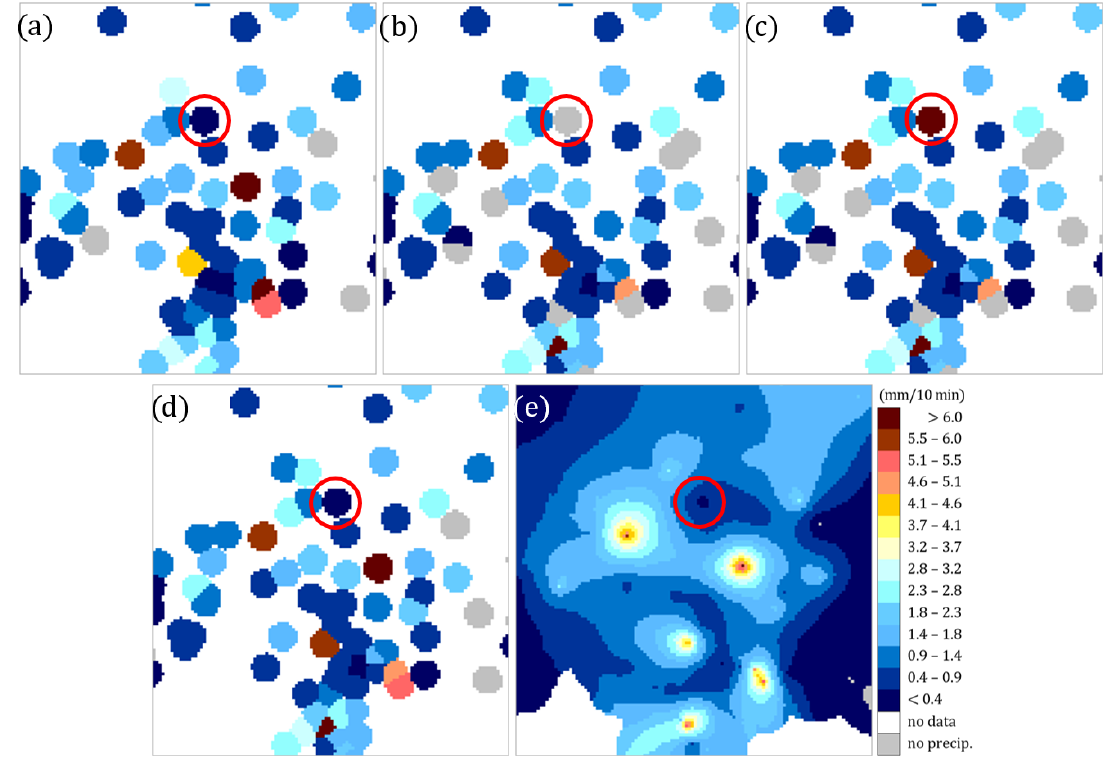
Figure 7. Example of the RainGaugeQC performance after the introduction of an erroneous precipitation value: (a) original rain gauge data from unheated sensors ( G uh ; in all fields the Siercza rain station is marked with a red circle), (b) original data from heated sensors ( G h ) , (c) data from heated sensors disturbed with an artificial value at Siercza (10mm/10min), (d) rain gauge data after quality control, and (e) data after spatial interpolation. Data from 5 August 2021 at 17:40UTC for a fragment of the Polish domain (240km ×